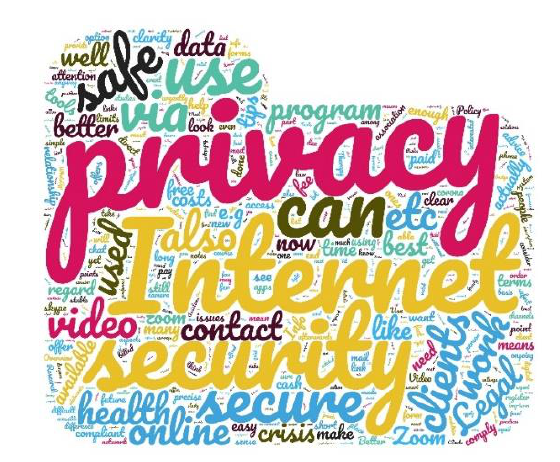
Figure 1. Word cloud on the answers to the free text question about which topics psychotherapists would like more information.